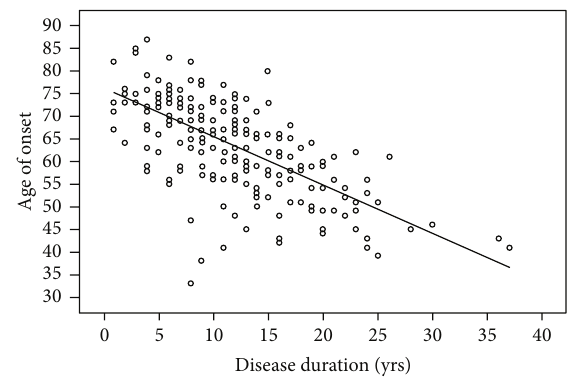
Figure 3: Scatter plot comparing age of onset to disease duration for each PD patient in our sample. Earlier age of PD onset was associated with longer disease duration in our sample as indicated by the trendline.